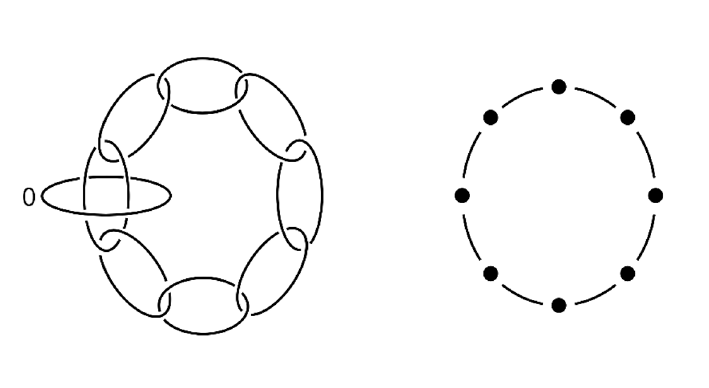
Figure 8 . Additional 0-framed unknots for plumbing graph with